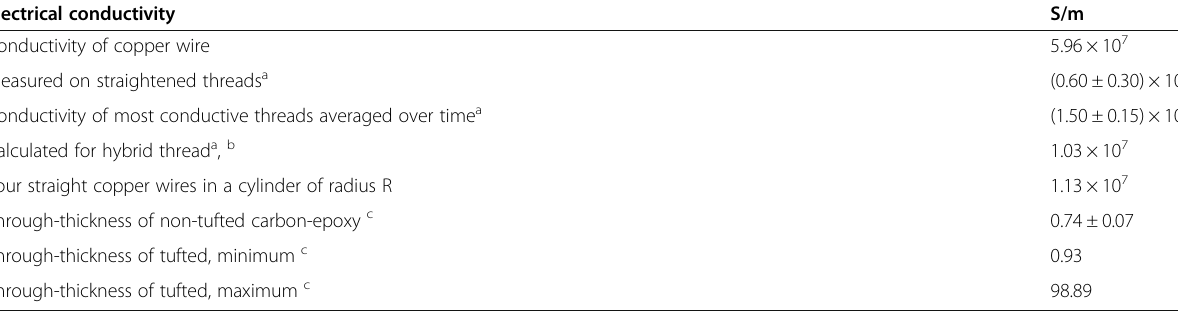
Table 2 Electrical conductivities of hybrid braided threads and composites tufted with them Electrical conductivity Conductivity of copper